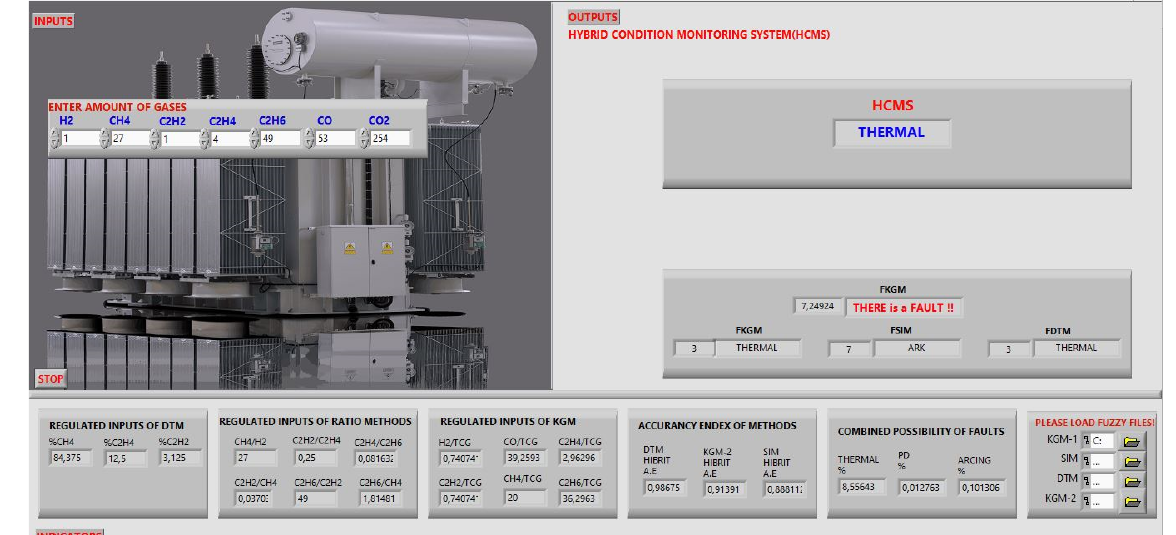
Figure 5. LabVIEW front